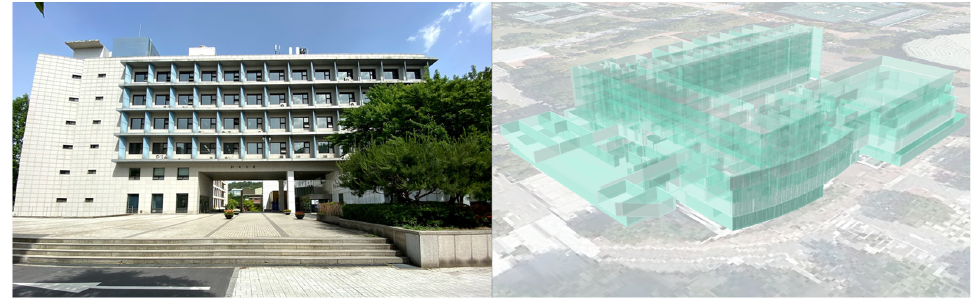
Figure 11. The study area for the use case implementation.